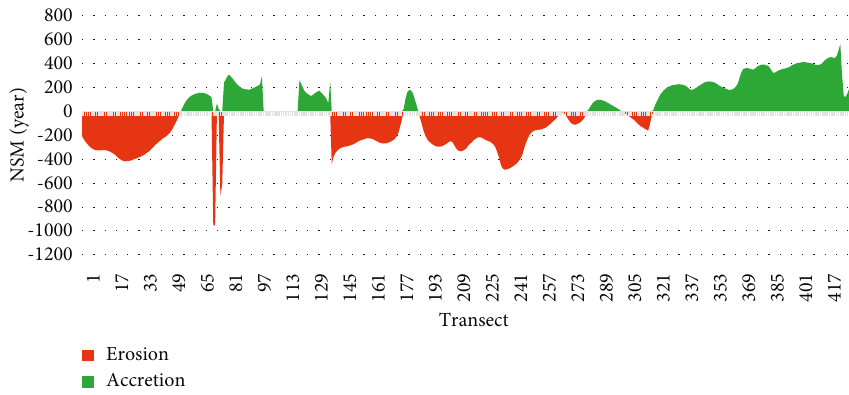
Figure 6: Dynamics of the coastline around Manoka Island between 1975 and 2017.